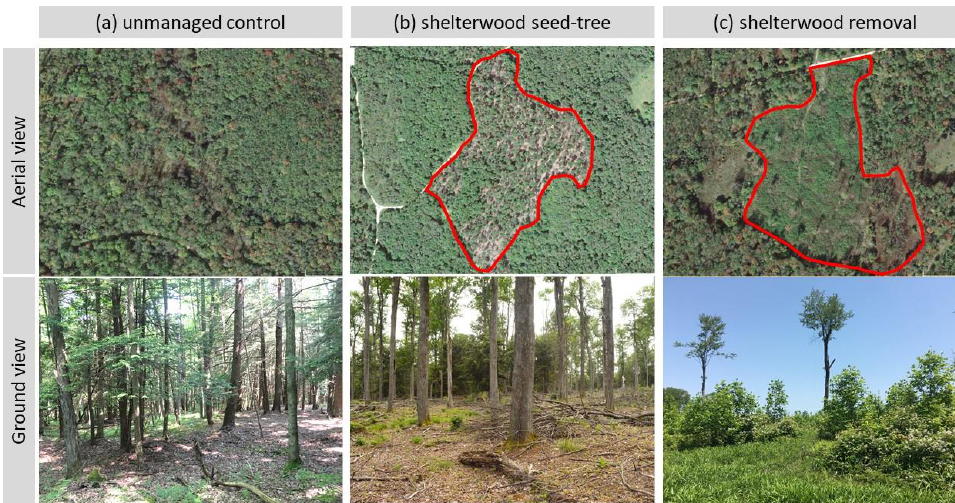
Figure 1. Aerial and ground views of unmanaged stand ( a ) and two different silvicultural manage- ment treatments ( b , c ) that are commonly used in the Allegheny National Forest located in Pennsylva- nia, USA. Red lines in ( b , c ) indicate the boundaries of management area. The shelterwood seed-tree treatment is conducted by removing approximately one-third of the overstory to encourage tree seedling development; mainly smaller trees and pole-sized understory trees are removed to provide at least 50 percent sunlight on the ground for seedling development. After approximately 3 to 15 years, the shelterwood removal treatment is conducted by removing the larger merchantable trees, typically leaving behind residual trees including den trees, snags, mast species, and uncommon species.